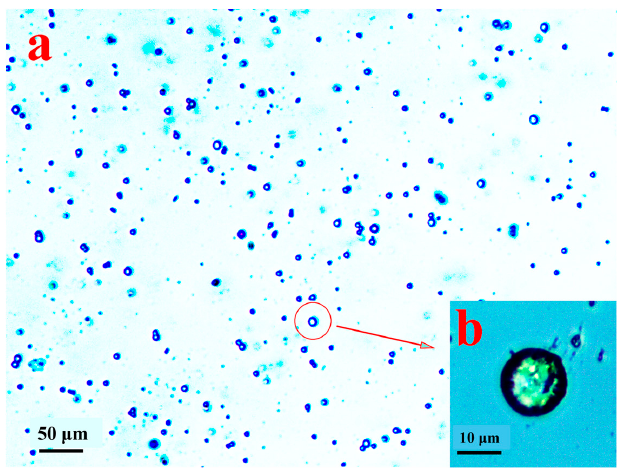
Figure 11. Morphology of microspheres of ABMP under an optical microscope: ( a ) overall distribution in a low-power image (100 times); and ( b ) the detailed morphology in a high-power image (400 times). Using PBS as a simulative fluid condition at 37 °C, the slow-release behavior of ABMP microspheres was assessed by observing the morphological changes of the microspheres. The microspheres were investigated at different time points, and the observed morphology is shown in Figure 12. Figure 12a shows the morphology of the control group, and Figures 12b–d show the morphology of the microsphere after 10, 20, and 40 h, respectively. The size of the microspheres became smaller with an increase in the release time. The release proportion was assessed according to the loss in the volume of the microsphere. The results indicated that 63.7%, 89.2%, and 97.2% of ABMP was released into the PBS after 10, 20, and 40 h, respectively. Compared with the ass-ABMP cube, the dissolution velocity was high.